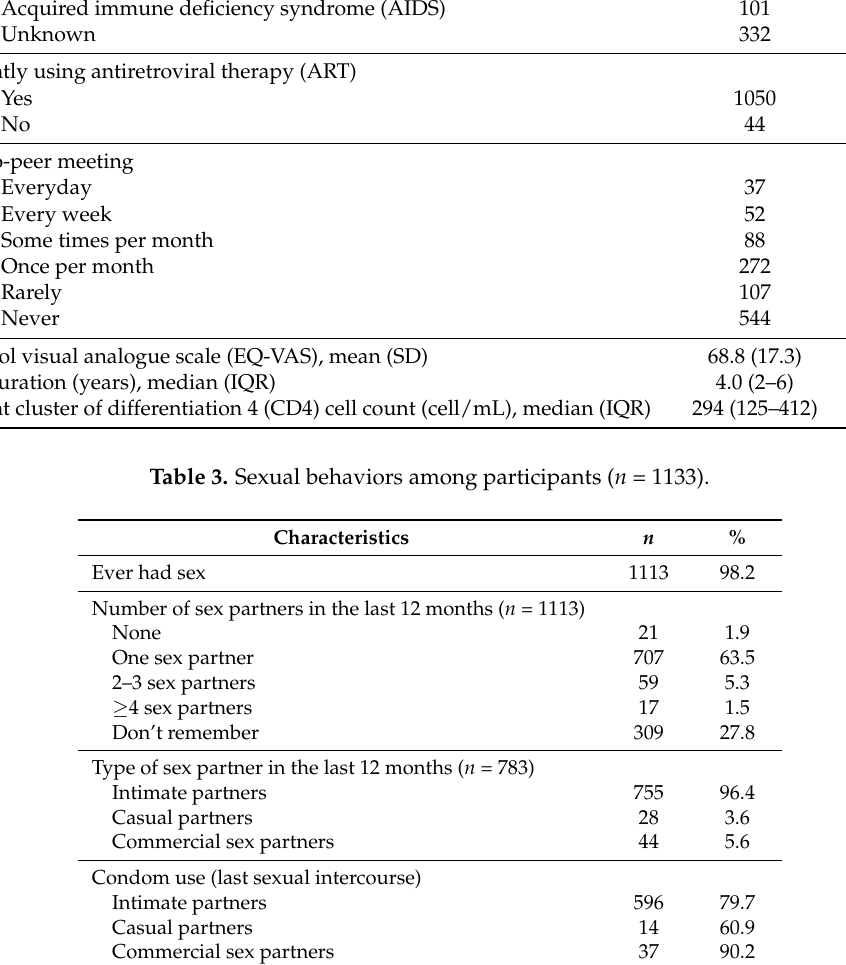
Table 4 assesses factors associated with the number of sexual partners, and condom use.